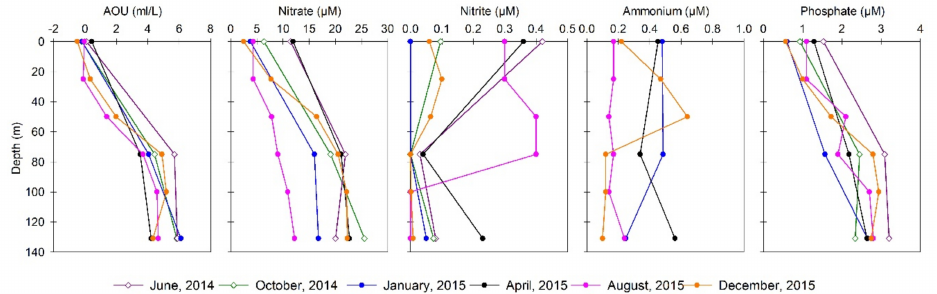
Figure 3. Biogeochemical conditions associated with Apparent Oxygen Utilization (AOU), nitrate, nitrite, ammonium, and phosphate distribution in the water column during the selected months sampled (June and October of 2014, January, April, August and December 2015). Greenhouse distribution in the water column is present in Figure S5. Nitrous oxide presented a higher concentration at the oxyclines and deep subsurface waters during August and December 2015. Carbon dioxide presented higher concentration in bottom waters, whereas low methane concentrations were detected throughout the water